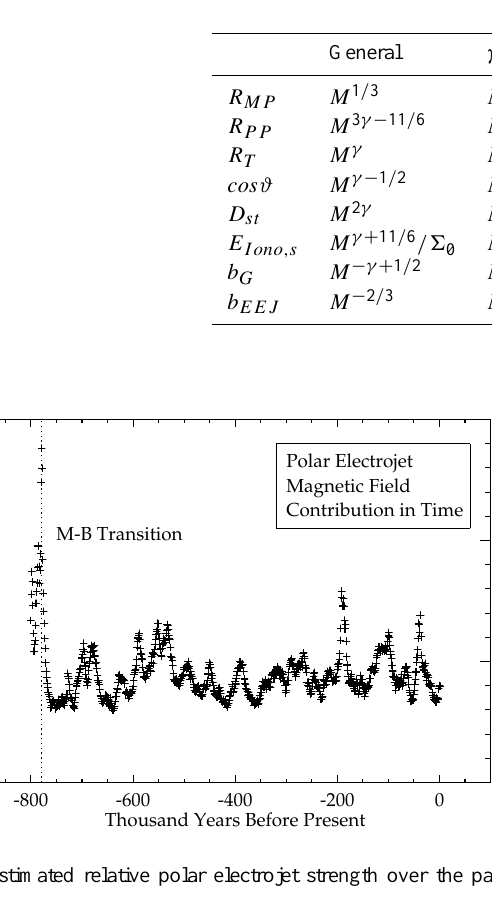
Table 1. Scaling relations for various magnetospheric parameters.